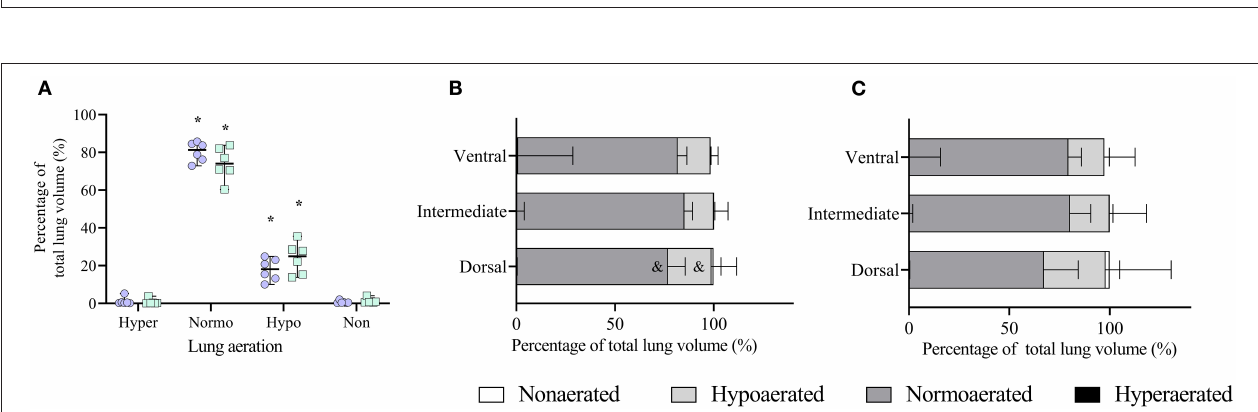
FIGURE 4 | Analysis of the craniocaudal distribution of lung aeration in six obese dogs undergoing anesthesia. It can be seen that most of the midcranial lung tissue is normoaerated, whereas hypoaeration becomes predominant in the caudal lung. Hyperaerated tissue and nonaerated tissue are scarce.